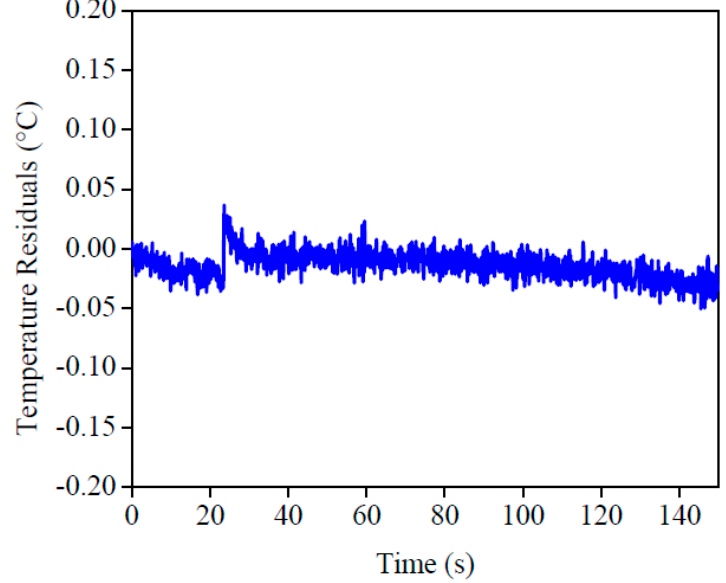
Figure 14. Residuals of temperature of AISI 304.